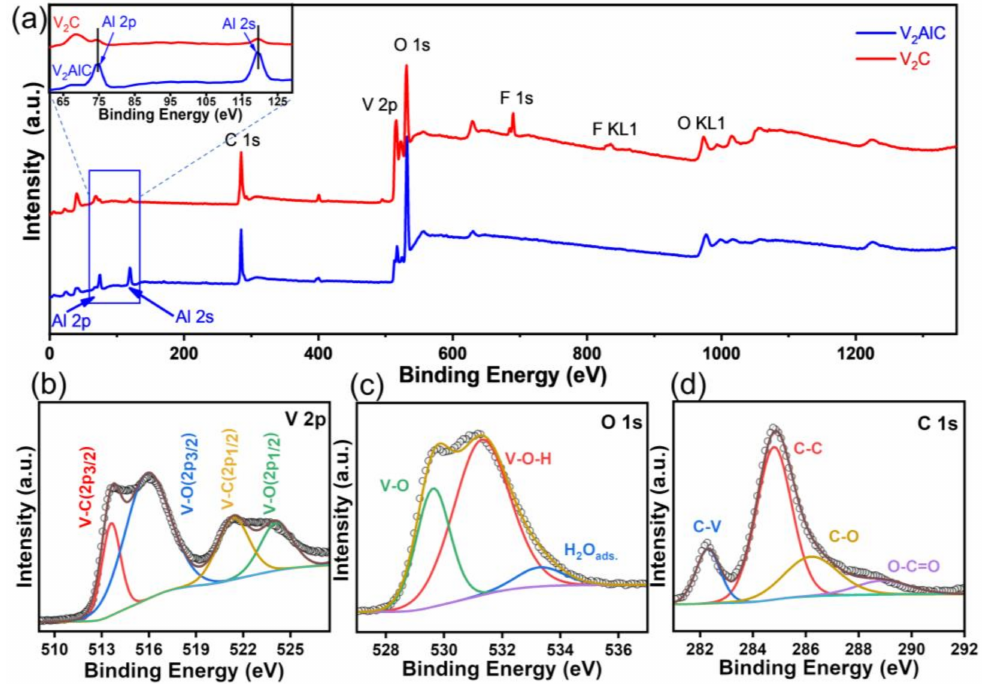
Figure 5. ( a ) The XPS spectra of V 2 AlC and V 2 C, ( b ) V 2p, ( c ) O 1s, ( d ) C